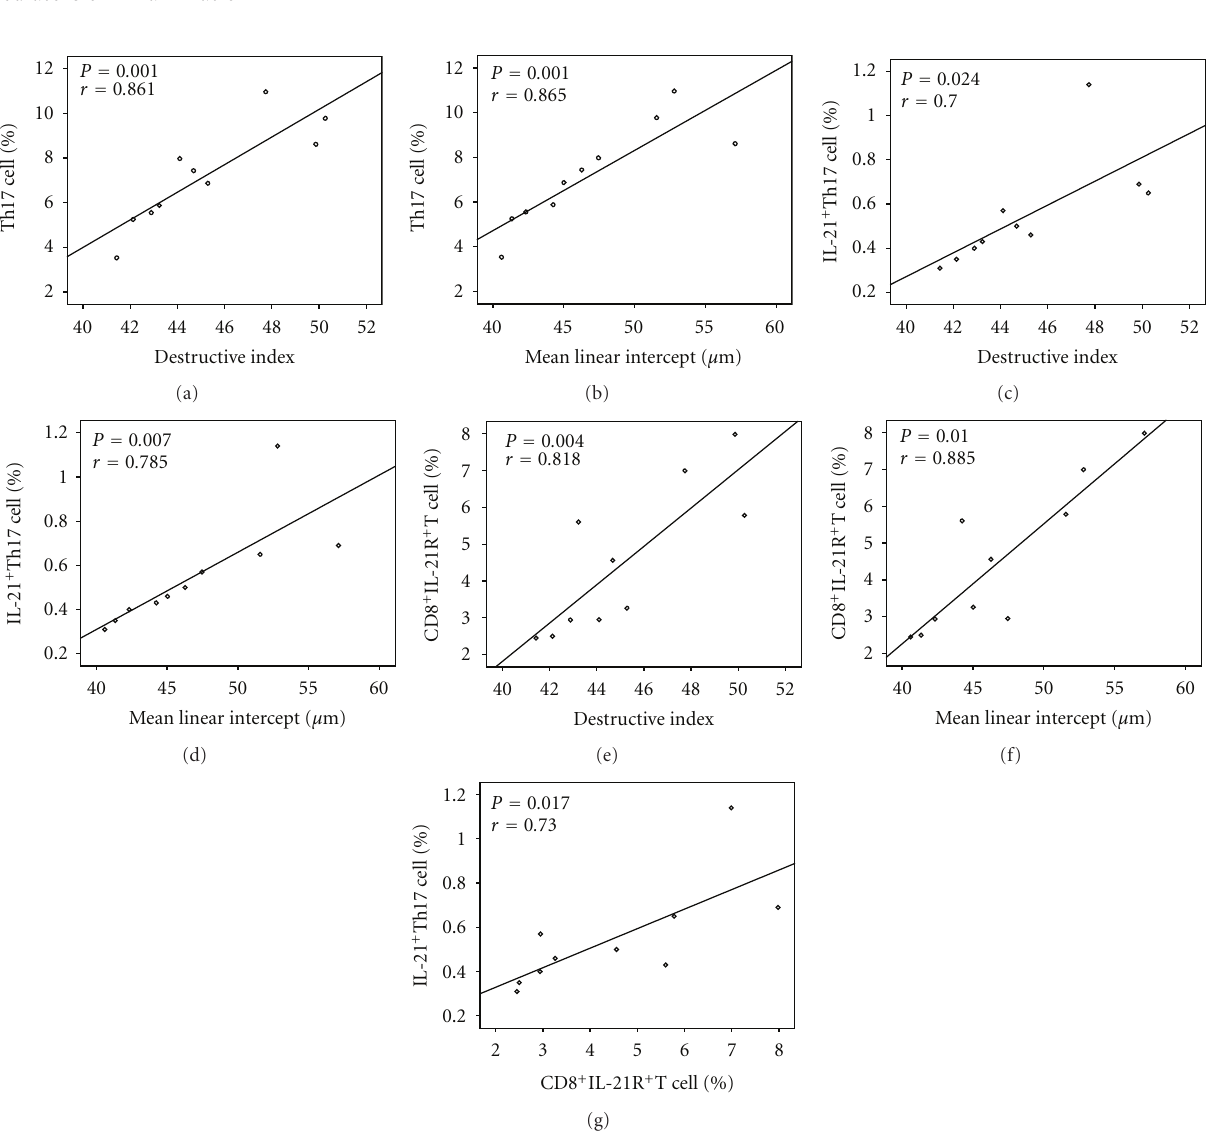
the number of CD8 + T cells found in the lungs of